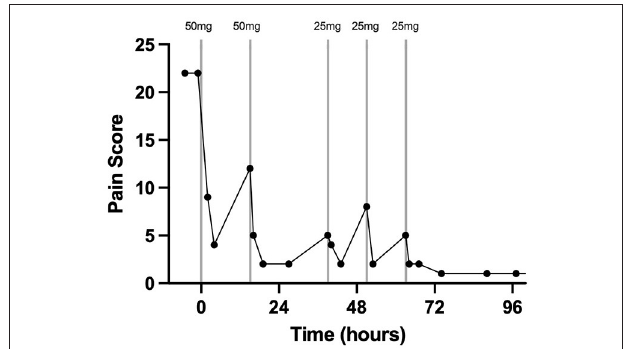
FIGURE 2 | Heart rate in beats per minute 2h prior to, during, and after treatment with morphine via a C1-C2 epidural catheter in a horse. The vertical lines indicate the timing and dose of morphine administration. Each data point represents a heart rate. Time zero is the time of C1-C2 catheter placement and first morphine